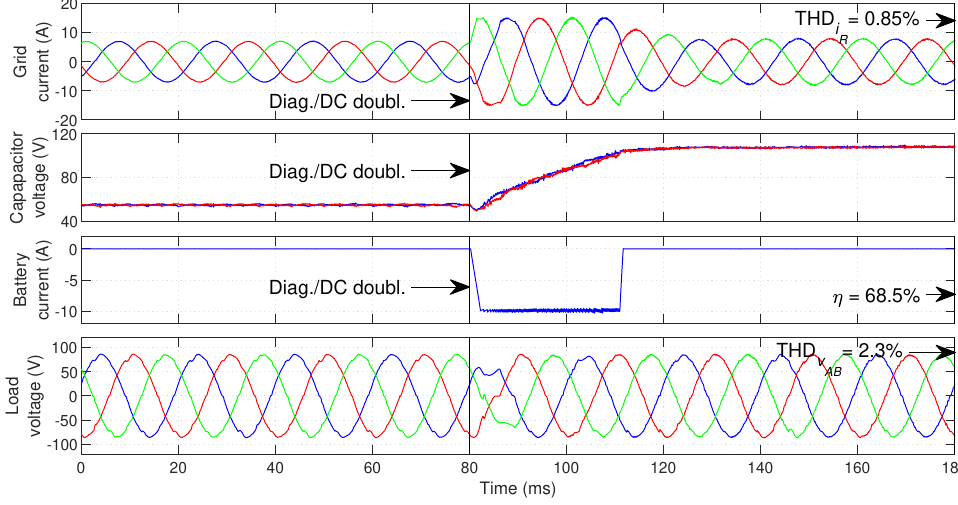
Figure 22. Normal and fault-tolerant UPS operation when an OC occurs in outer IGBT S A 1 of the